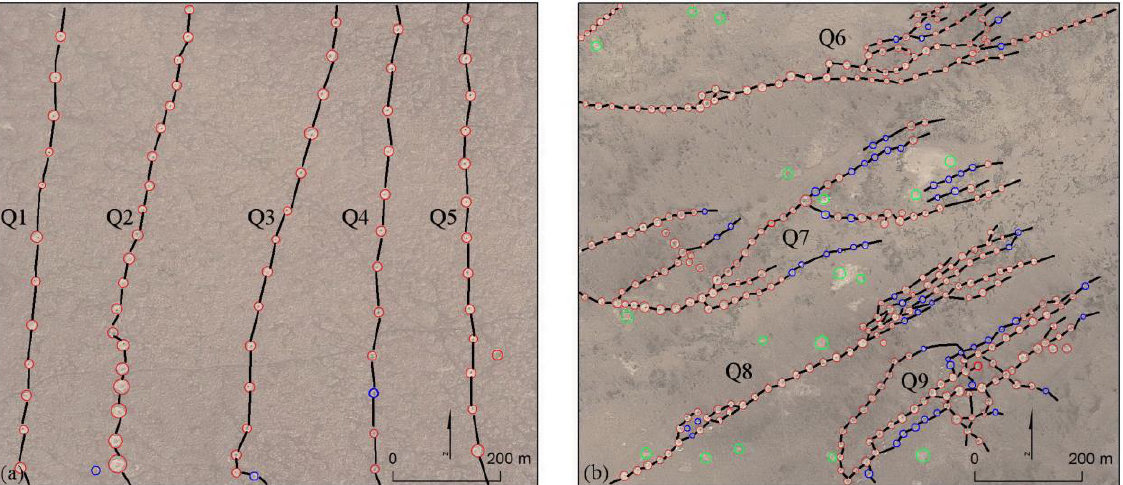
Figure 8. Mapping qanats based on automatic extractions and manual identifications.